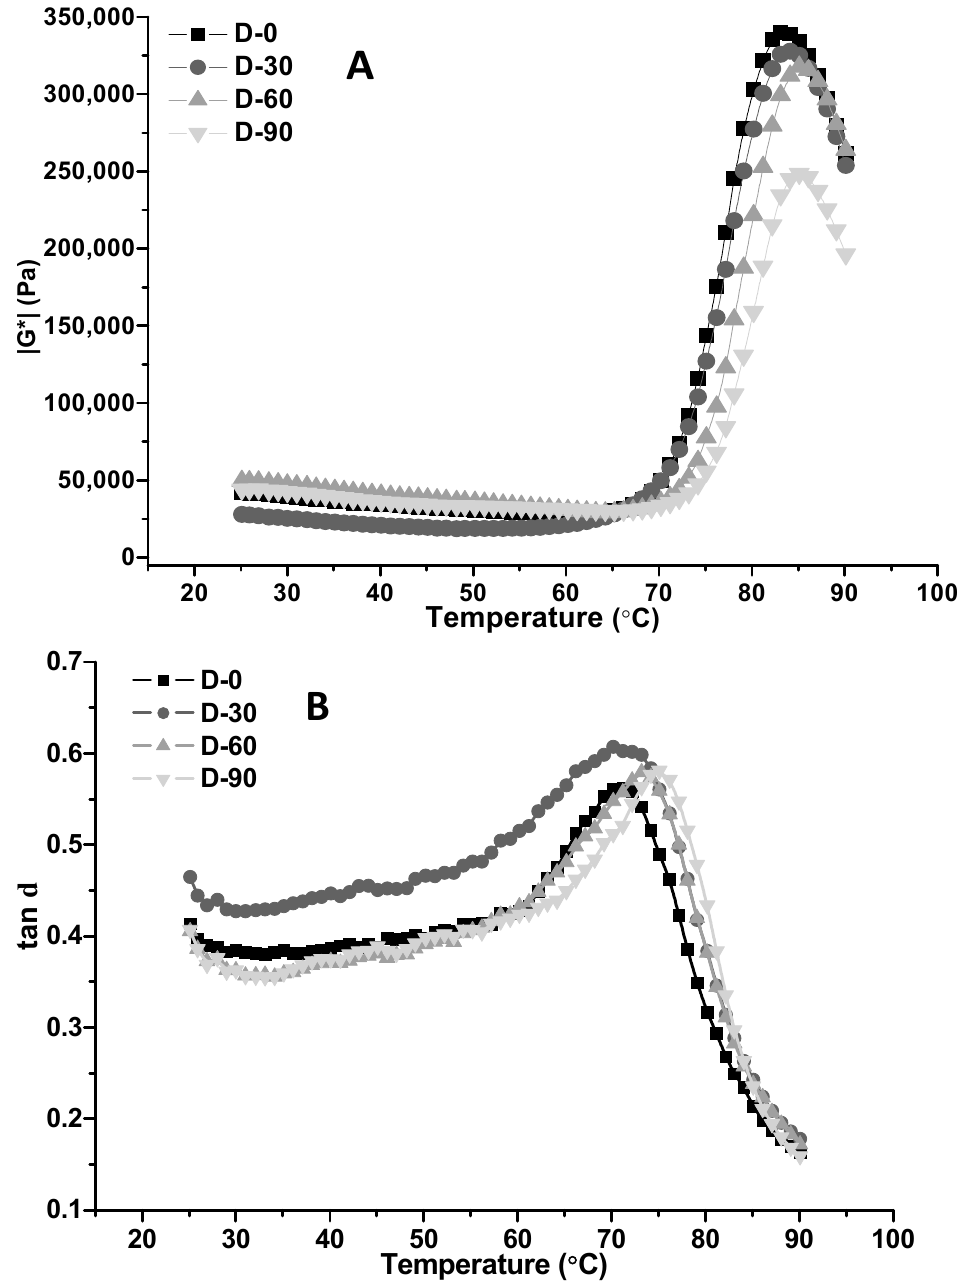
Figure 4. Effect of proofing on the complex shear modulus |G * | ( A ) and loss factor tan δ ( B ) of CS–HPMC gluten-free dough during the dynamic temperature sweep.